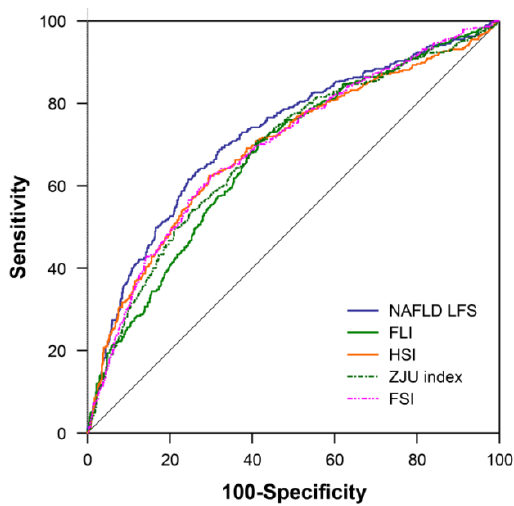
Figure 2. Area under the receiver operator characteristics (AUROC) of each prediction model for predicting fatty liver.